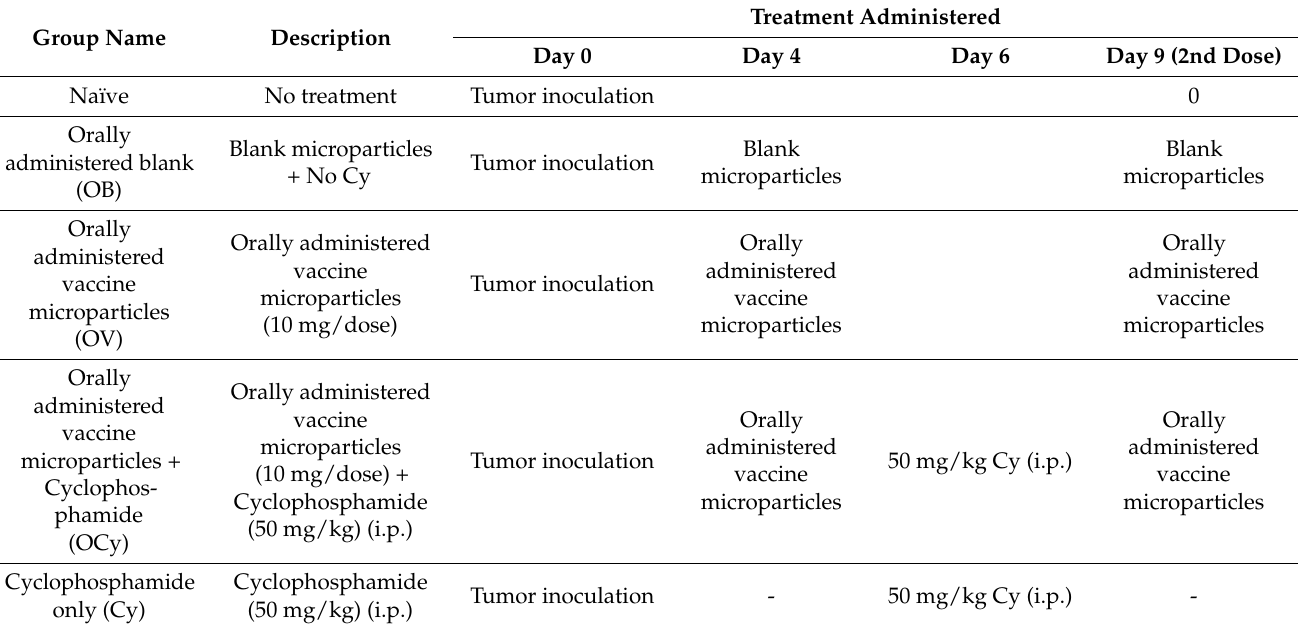
Table 1. In vivo vaccination study: group distribution and dose